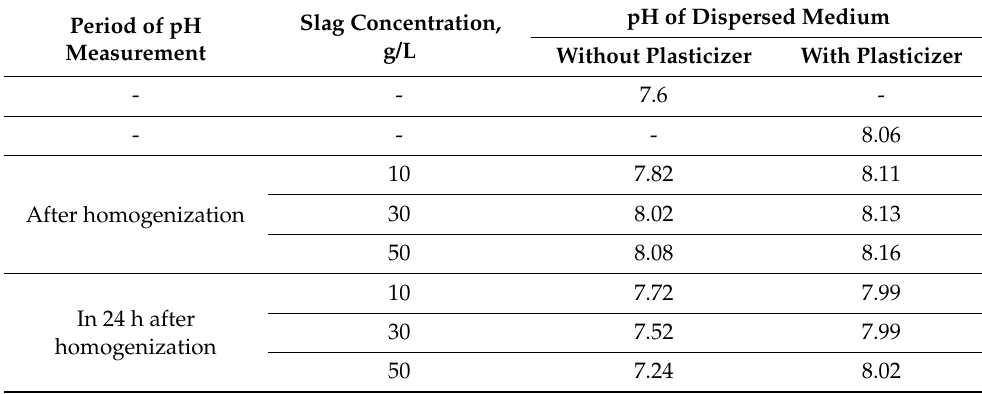
Table 13. pH values of the dispersed medium in the “slag-water-plasticizer” system. pH of Dispersed Medium Slag Concentration, Period of pH g/L Measurement Without